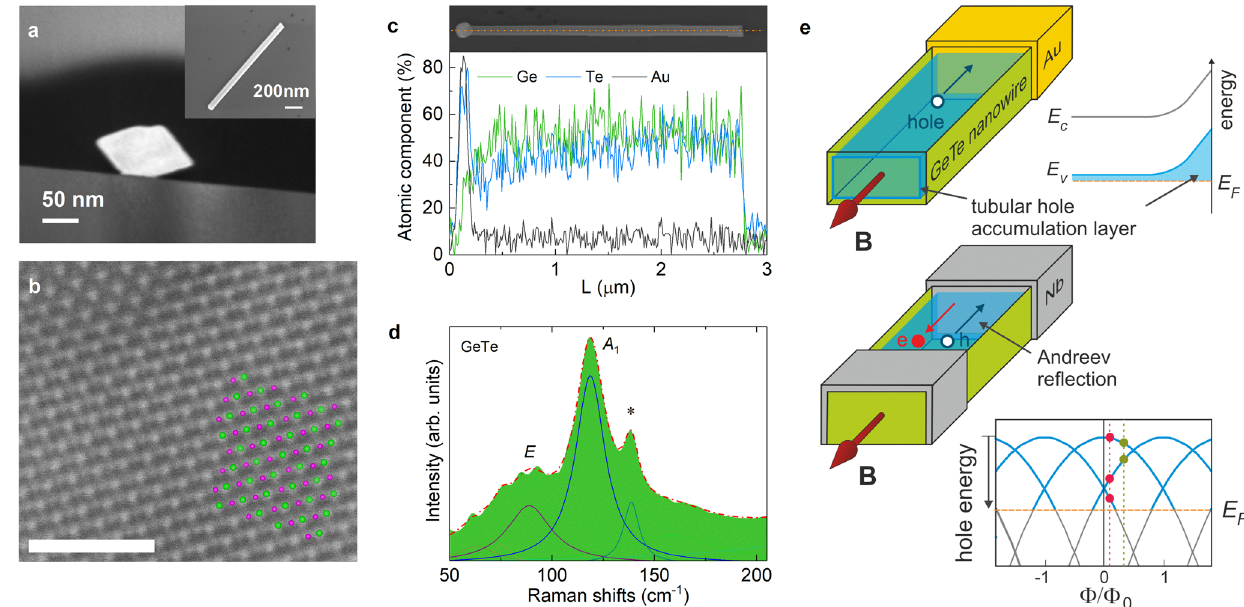
Fig. 1 Structural characterization and schematics of carrier transport. a Scanning transmission electron micrograph of GeTe NW in cross section. b HAADF image of GeTe NW cross section obtained via aberration corrected STEM with evident trigonal crystal structure, where light green atoms represent Te and magenta colored atoms indicate the position of Ge atoms. Scale bar: 2 nm. c A SEM image of a GeTe nanowire and the corresponding atomic composition along the nanowire from Energy dispersive X-ray spectroscopy. d Experimental and fi tted Raman spectra (solid lines) with mode assignments of a GeTe single nanowire. E and A 1 are the fi rst-order Raman-active modes while the feature (*) arises from surface oxidation. e Top: Schematics of a GeTe nanowire with a tubular hole accumulation layer and a magnetic fi eld along the wire axis. The scheme on the right shows the upwards bending of the bands at the surface, with E F the Fermi energy as well as E c and E v the conduction band bottom and valence band top, respectively. Bottom: schematics of a GeTe nanowire contacted with Nb electrodes. At the interface Andreev re fl ection occurs. The schematics on the right shows the energy spectrum of hole states in a tubular conductor for different angular momenta as a function of the normalized fl ux Φ / Φ 0 for E kin = 0. Note that for hole states the energy increases downwards and the effective mass is positive. The red and green dots indicate the occupied channels at different fl ux